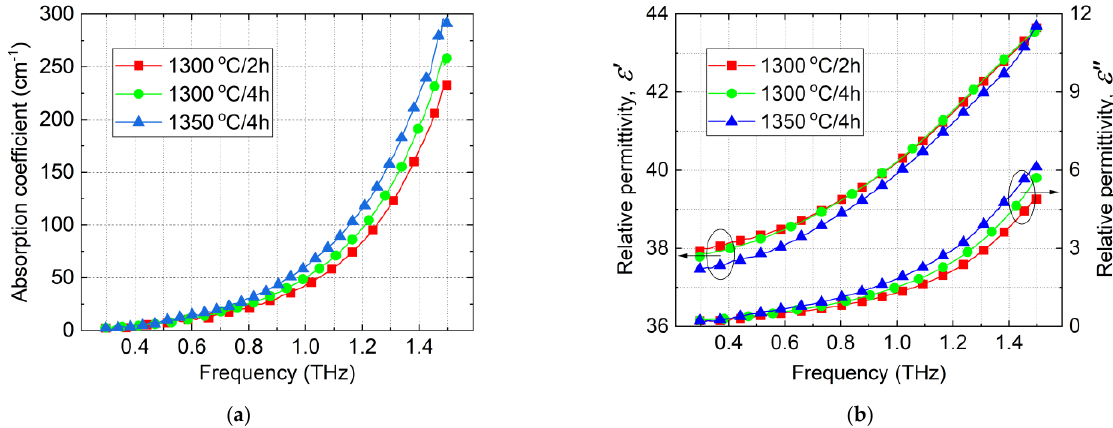
Figure 3. Frequency dependence of the absorption coefficient ( a ) and complex relative permittivity ( b ) versus sintering condition for ZST ceramics.